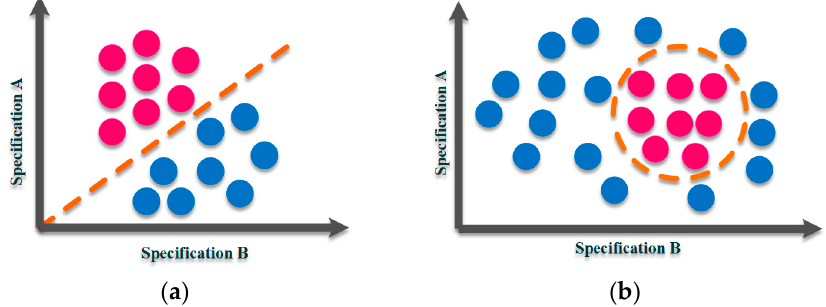
Figure 16. The basic structure of SVMs: ( a ) linear SVM model; ( b ) non-linear SVM model.